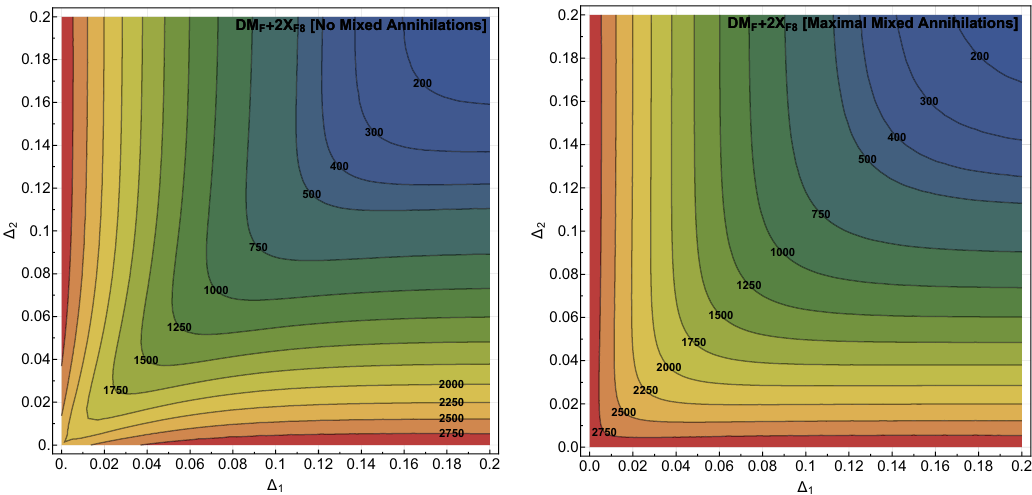
Figure 2 . Contours of dark matter masses in GeV required to obtain the relic abundance measured by Planck as a function of the two mass splittings, (cid:1) 1 and (cid:1) 2 . The dark matter is a Dirac fermion, while both coannihilation partners are fermionic color octets. The left (cid:12)gure shows the case with no mixed annihilation, whereas in the right (cid:12)gure the mixed annihilation rate is maximally saturating condition